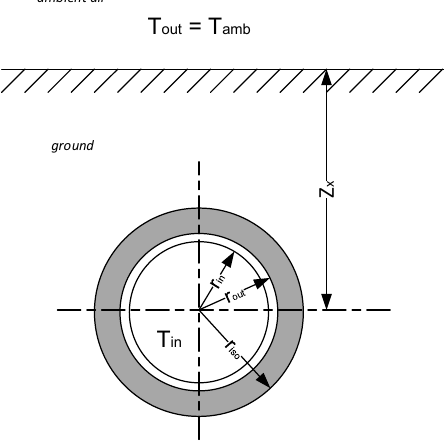
Figure 2. Cross section of an exemplary pipeline. Energies 2019 , 12 FOR PEER REVIEW